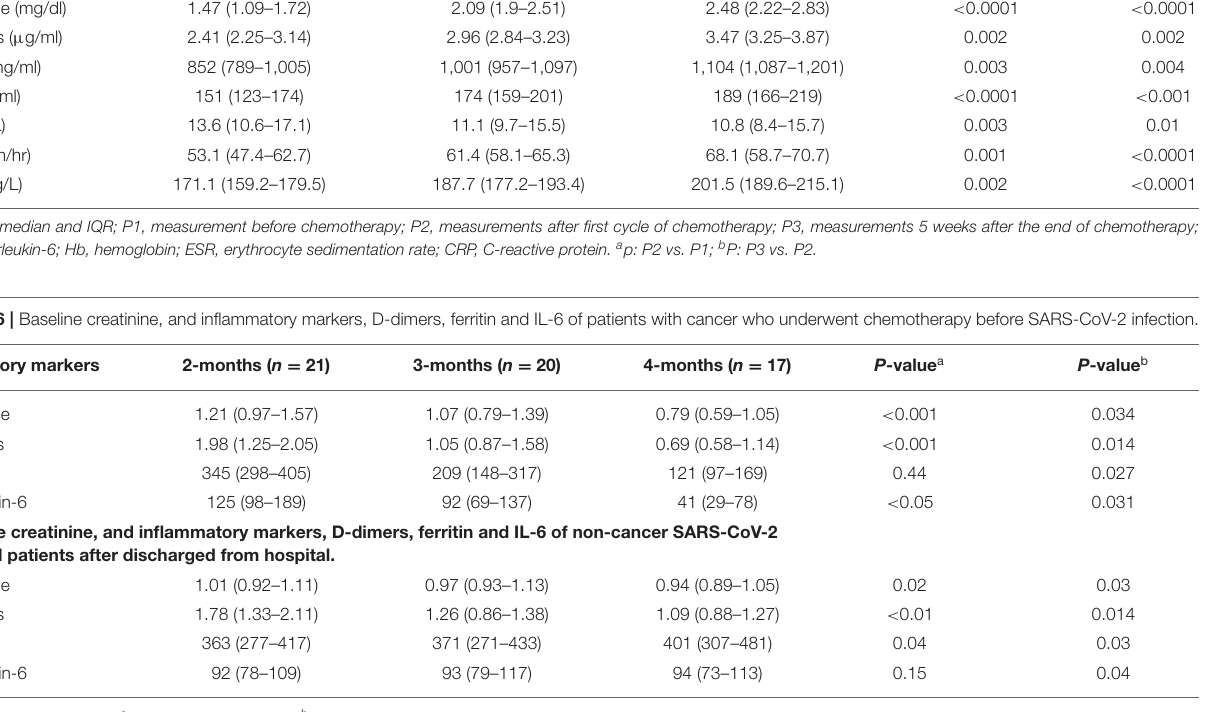
TABLE 5 | Baseline creatinine, and inflammatory markers, D-dimers, ferritin, and interleukin-6 (IL-6) of patients who were undergoing chemotherapy after recovery from SARS-CoV-2 infection. Parameters